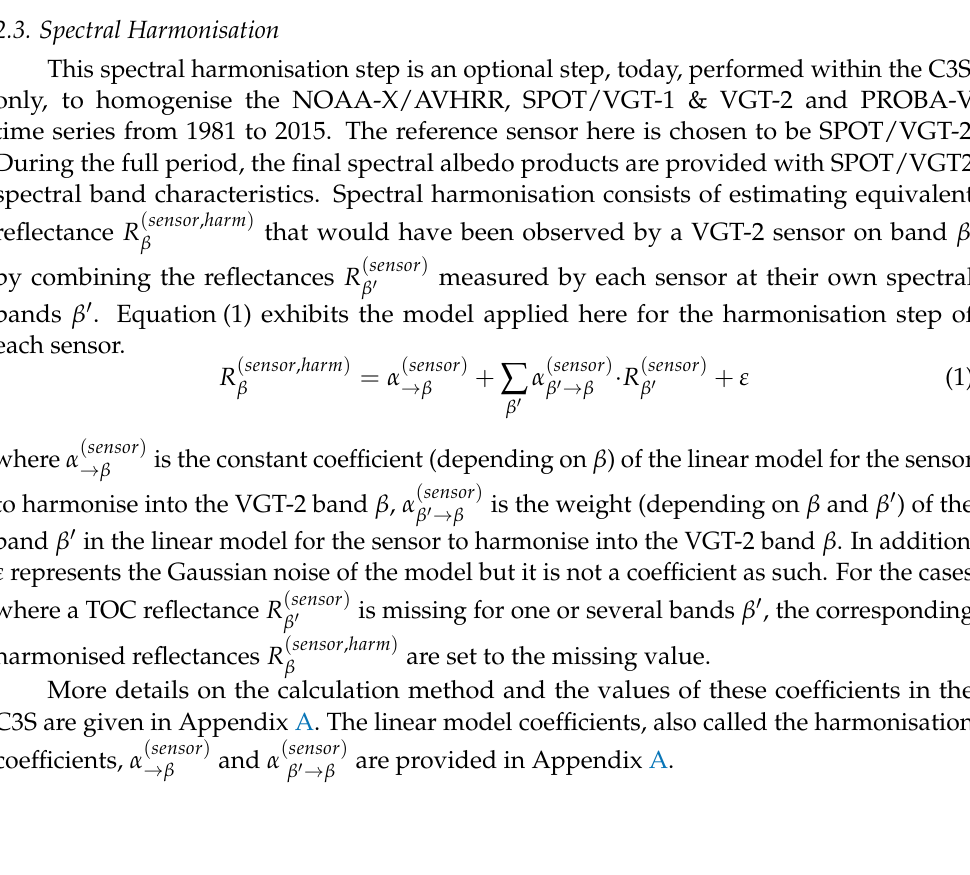
Figure 1. Flow diagram of the surface albedo retrieval algorithm. The spectral harmonisation (step 2) is optional. The boxes at the right side are the inputs: i.e., aerosol optical depth (AOD), water vapour (WV), ozone (O3), digital elevation model (DEM) etc. The boxes in grey colour are the outputs of each module (box bordered by dashed